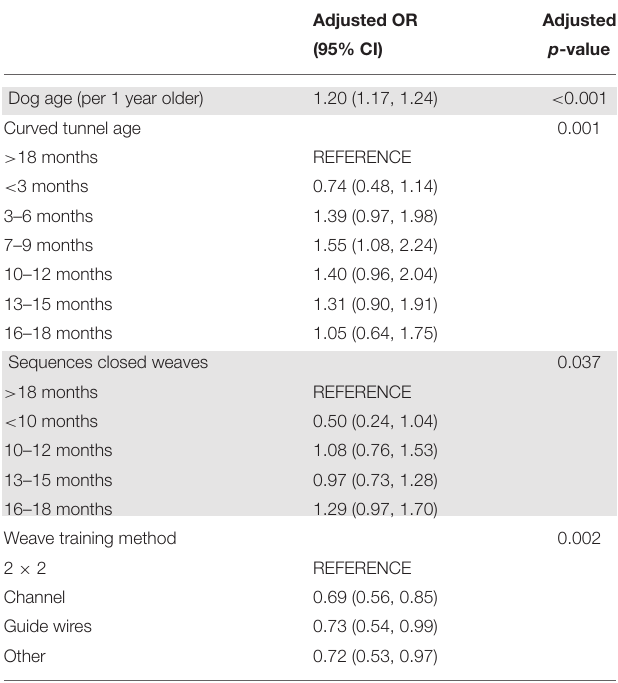
TABLE 5 | Coefficients from adjusted model with training level factors for any injury.